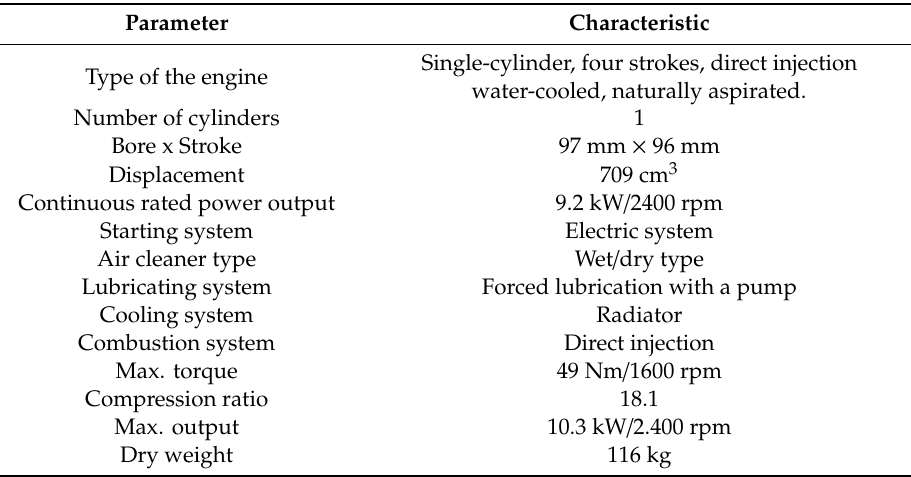
Table 1. Specifications of the test engine.